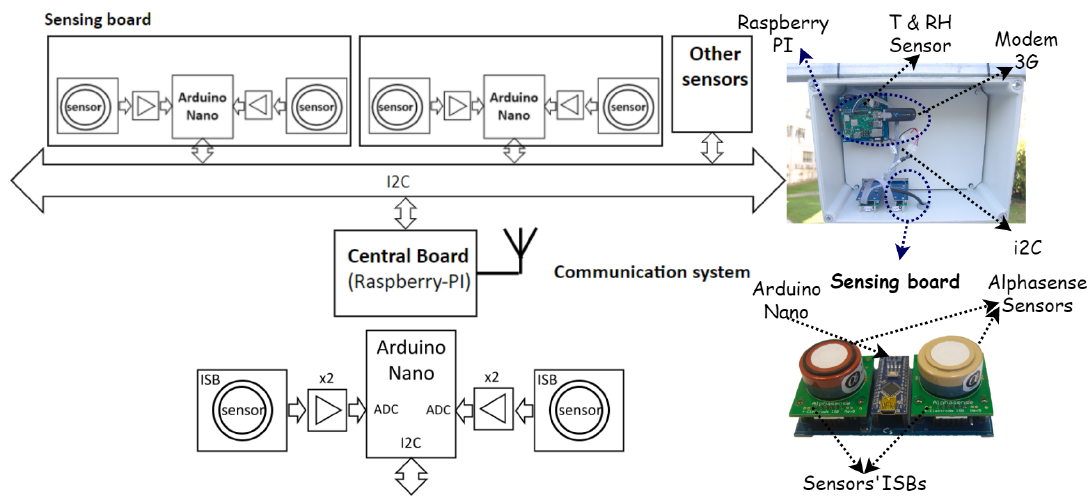
Figure 1. Air pollution data capture prototype Captor node on ( top ), and the Captor’s sensing board on ( bottom ). The prototype node has a Raspberry-based central processing unit connected to the sensing boards via an I2C bus. Each sensing board has an Arduino Nano microcontroller unit in charge of collecting the measurements from the electrochemical sensors and sending them to the Raspberry unit. The collected samples are then transmitted to the cloud via a 3G